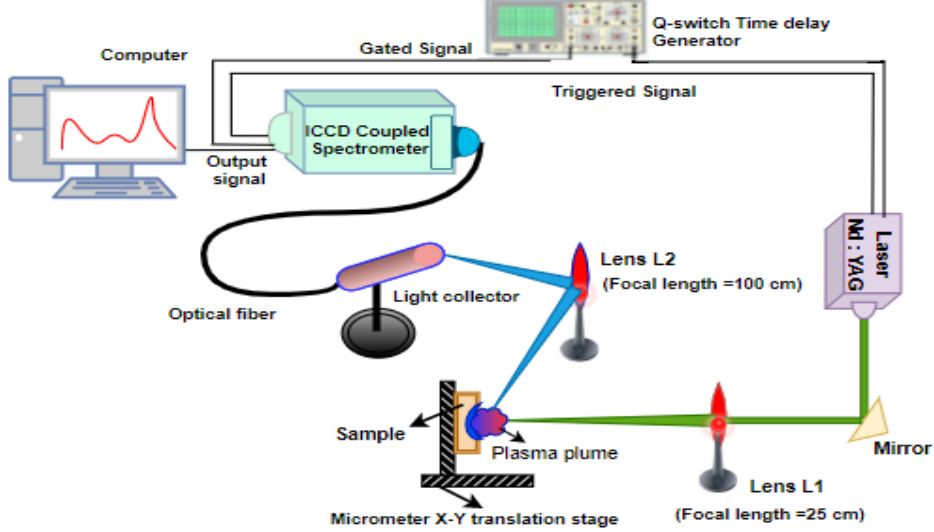
Figure 2. Laser-induced breakdown spectroscopy setup.